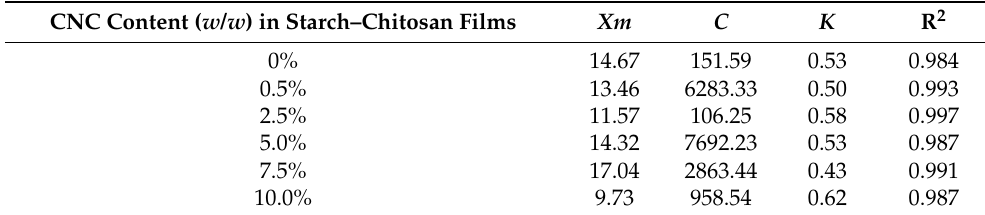
Table 3. GAB mathematical model parameters and regression coefficient, R 2 , calculated for compo- site starch–chitosan films with CNC.